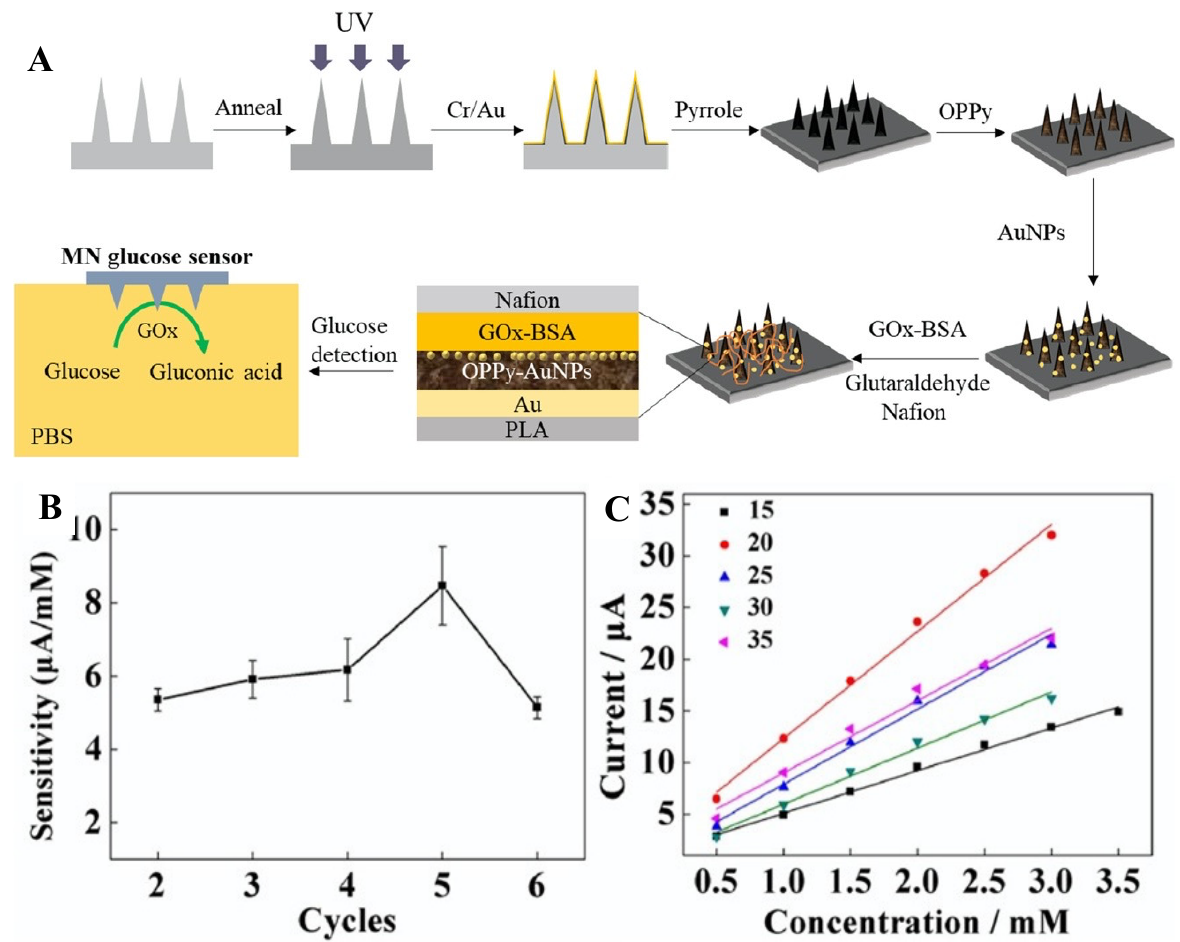
Figure 1. ( A ) The fabrication process of Nafion/GOx/AuNPs/overoxidized polypyrrole/Au MN array glucose biosensor. ( B ) The sensitivity curves of glucose biosensors with different cycles. ( C ) The calibration curves of glucose biosensors with different concentrations. Reprinted with permission from ref. [153] Copyright 2020, Elsevier.